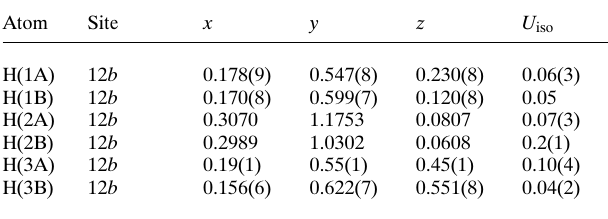
Table 2. Atomic coordinates and displacement parameters (in Å 2 ) . Table 1. Data collection and